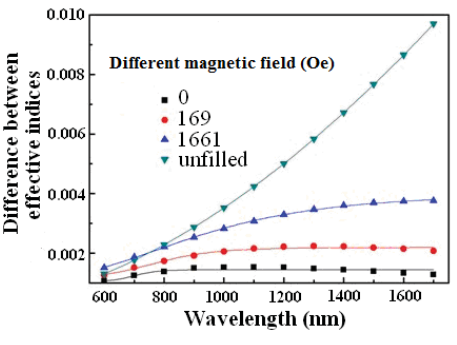
Figure 12. Difference between cladding-mode and core-mode effective indices for different applied magnetic fields